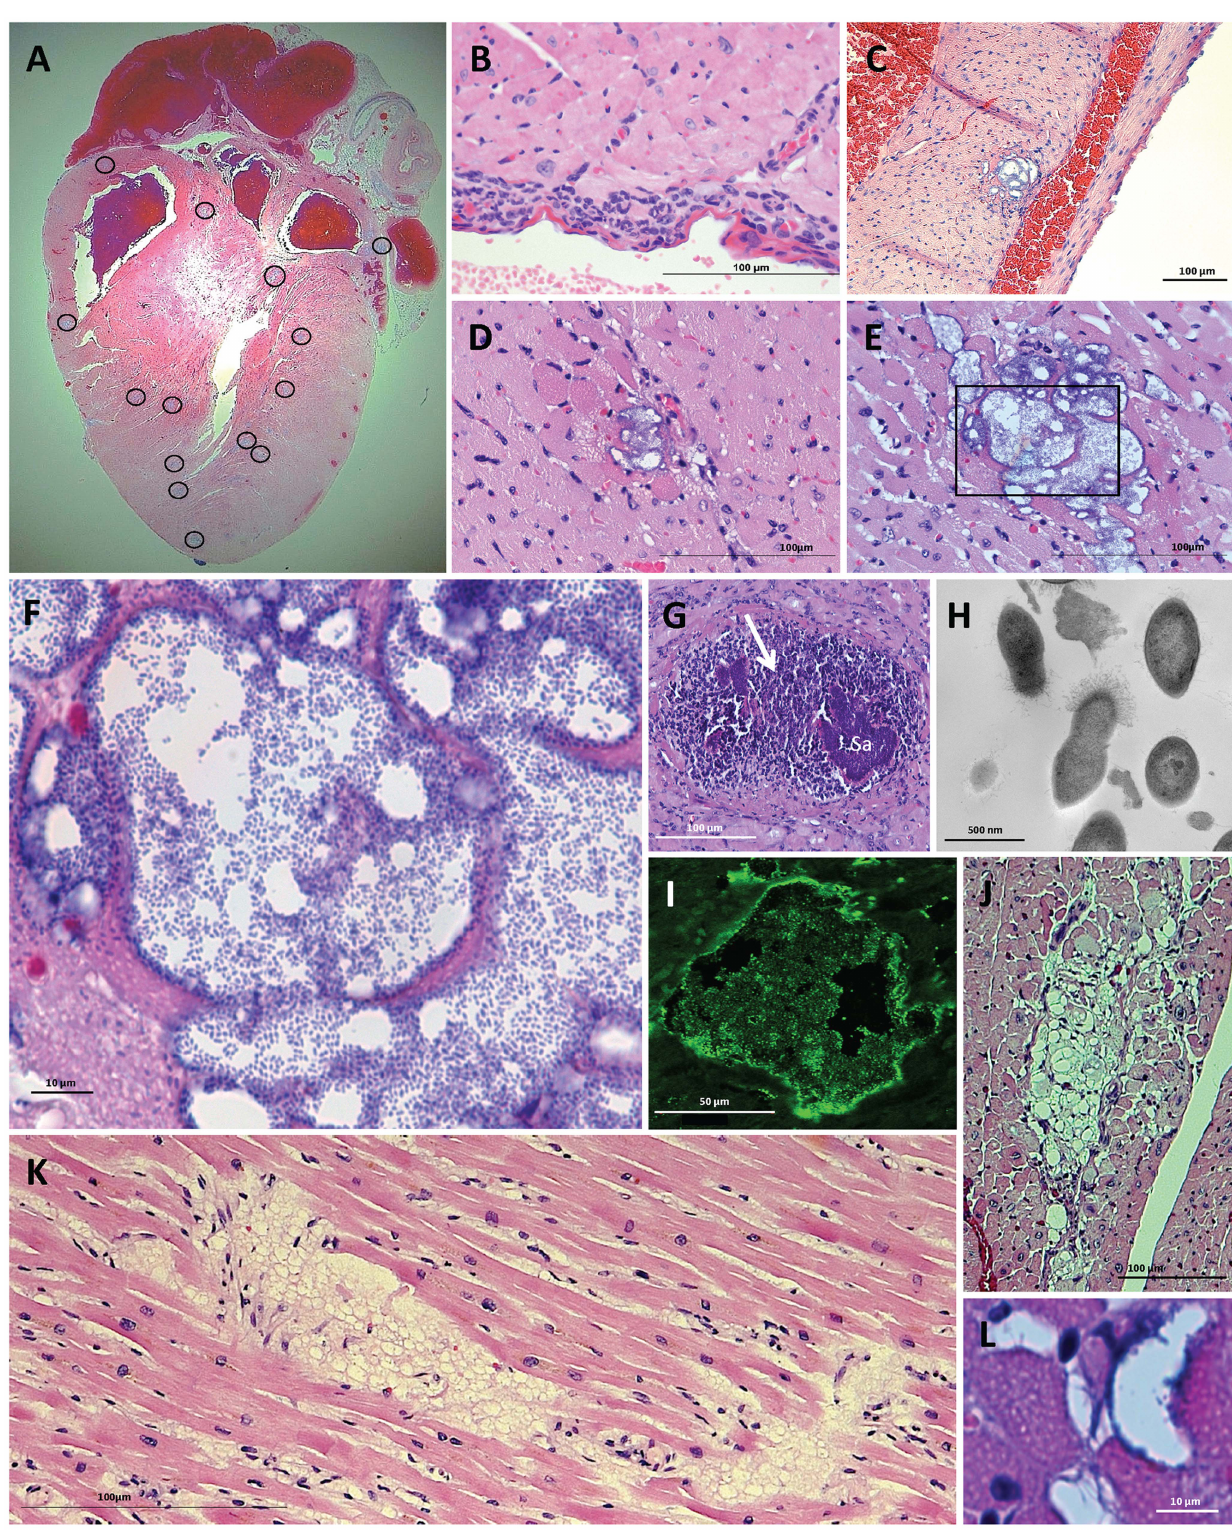
Figure 2. Cardiac lesions form as the result of IPD. H&E stained cross section of a heart obtained from a BALB/c mouse 30 h post- intraperitoneal challenge with TIGR4. A) Cardiac microlesions were randomly distributed throughout the mouse myocardium. The circled regions demarcate lesion areas. B) Pericarditis was observed in rare mice at 30 h post infection. C) Cardiac microlesions were often observed to be adjacent to blood vessels. D&E) Representative images of cardiac microlesions seen at 24 h (n=8) and 30 h (n=11) post infection, respectively. F) Higher powered magnification of the 30 h cardiac microlesion shows S. pneumoniae bacterial aggregates within the microlesion. G) As a point of contrast, in mice infected i.p. with Staphylococcus aureus (Sa) abscesses were large and characterized by a robust neutrophil response (white arrow). Tissue